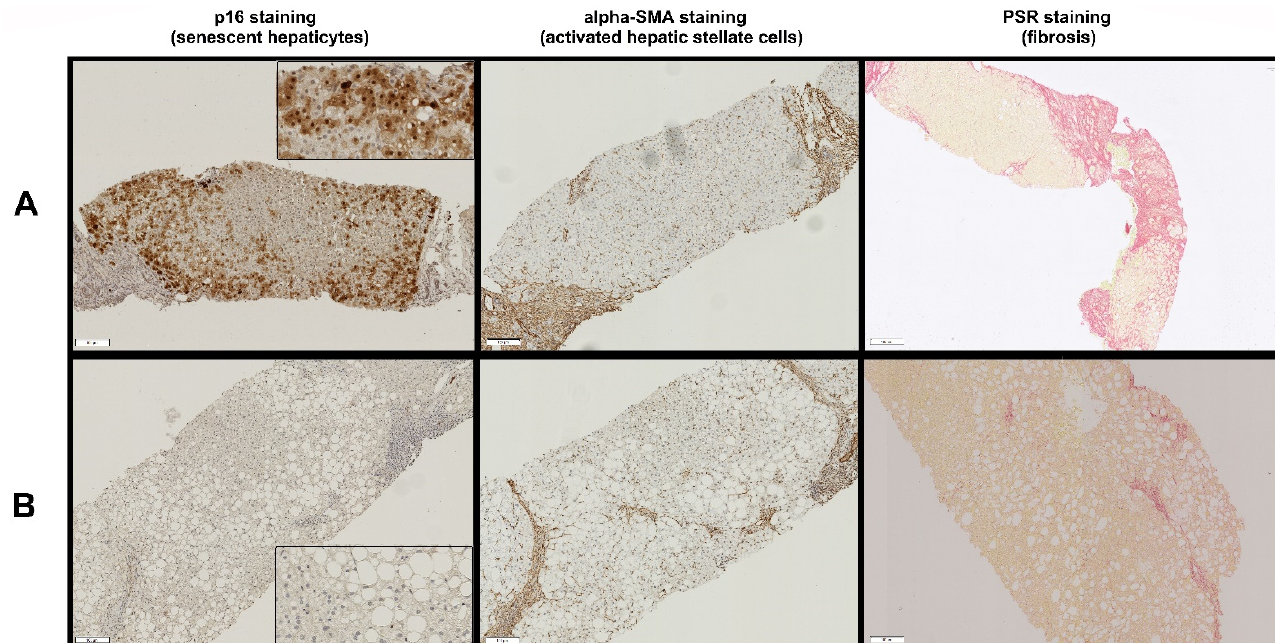
Figure 1. Associations between proportion of senescent hepatocyte (represented by positive p16 staining) and hepatic stellate cell activation (represented by α SMA expression) ( A ); proportion of senescent hepatocytes (represented by positive p16 staining) and liver fibrosis stage ( B ); hepatic stellate cell activation (represented by α SMA expression) and liver fibrosis stage ( C ).